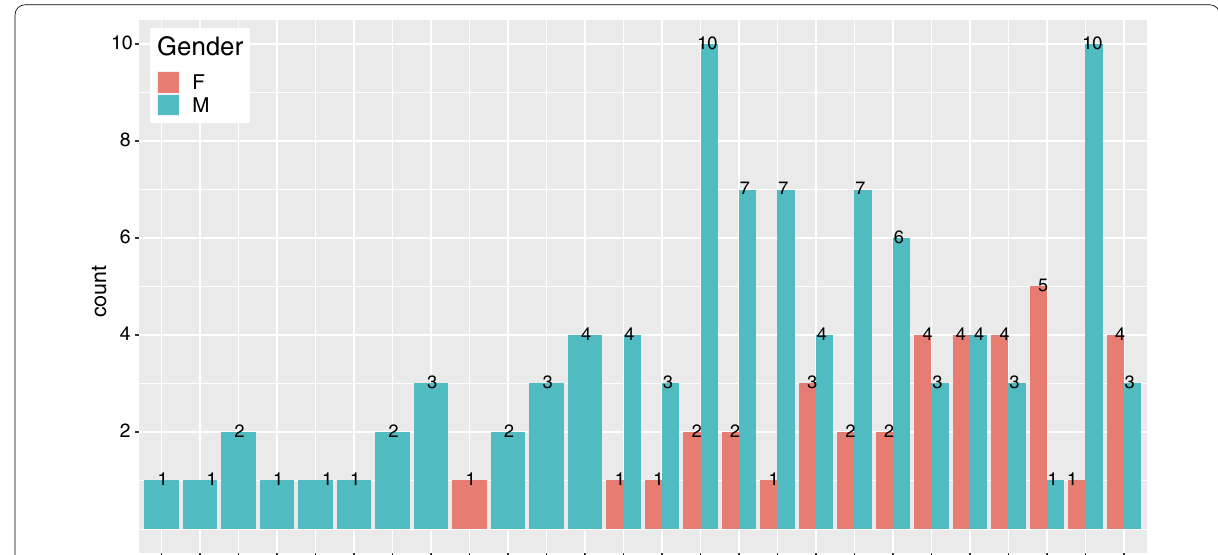
Fig. 11 Total appointed prizes per year, classified by gender